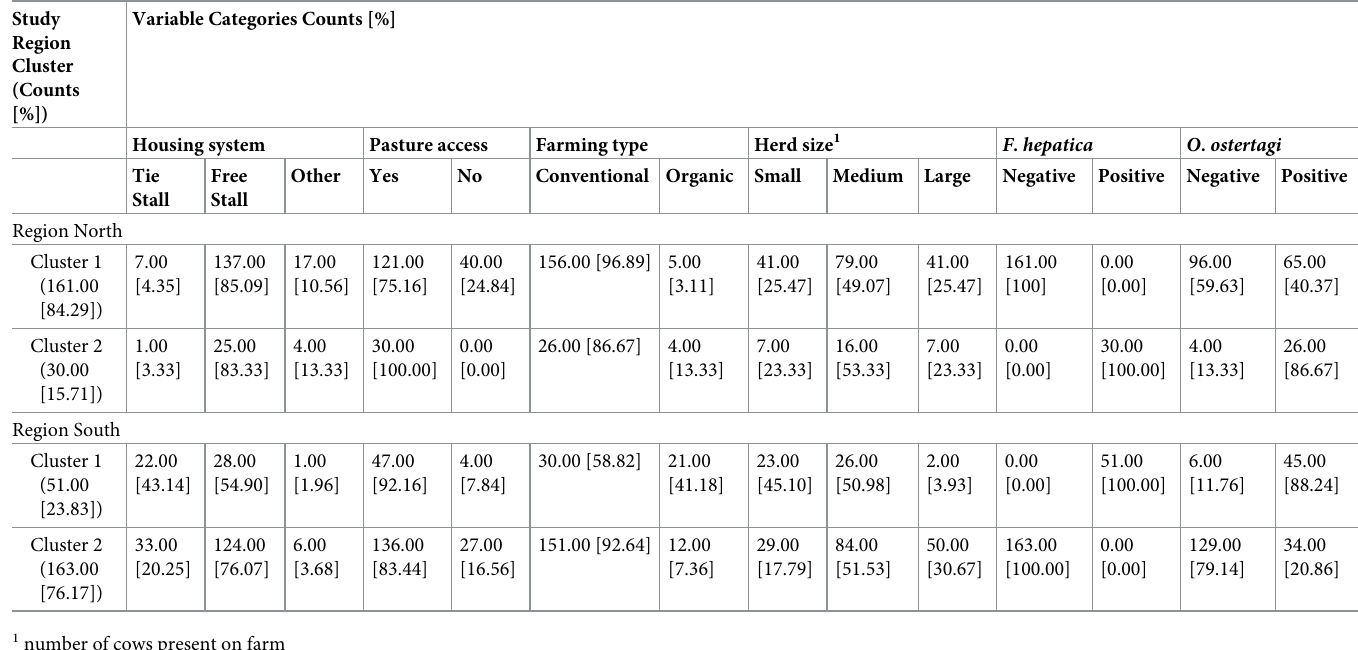
Table 3. Descriptive statistics (observations per cluster) of the F . hepatica cluster analysis in study regions North and South (categorical